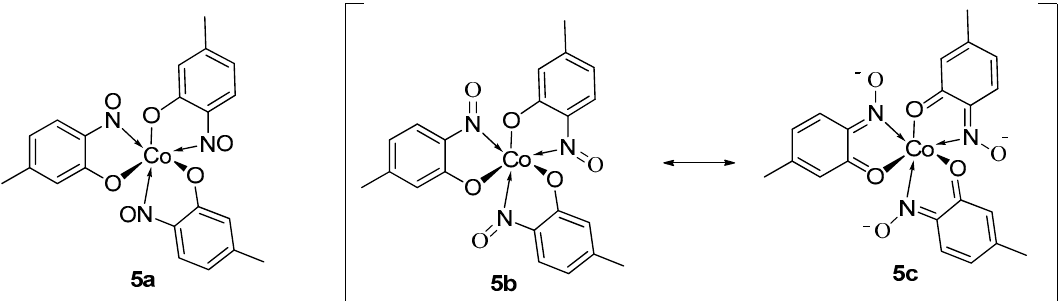
Figure 5. The suggested structure of Cobalt(III) tris (4-methyl-2-nitrosophenolato) ( 5a ) as specified in the publication by Mahmoud et al. and tautomeric forms ( 5b , c ) indicating potential hydrogen bond donor sites [54].